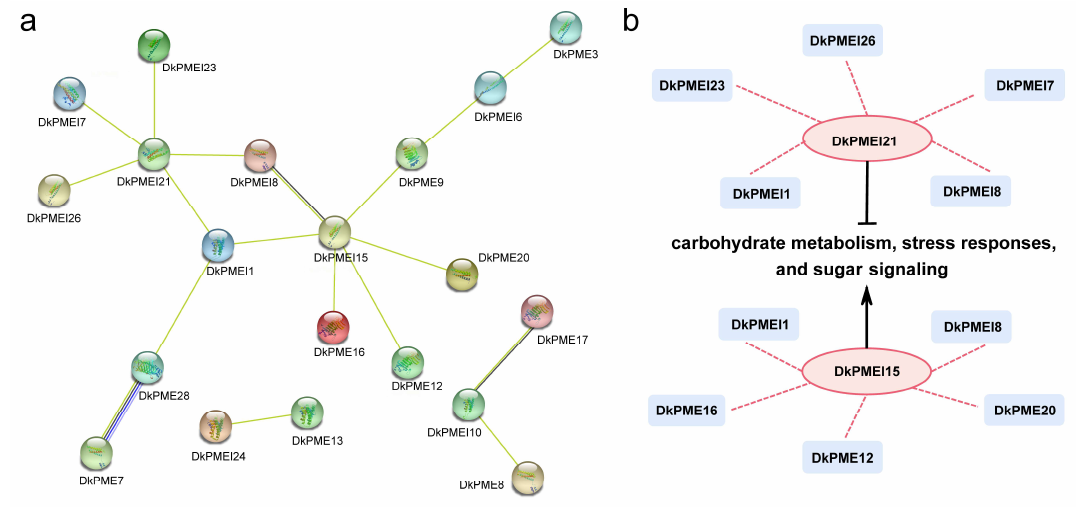
Figure 9. Functional network of DkPMEs and DkPMEIs: ( a ) Network of DkPMEs and DkPMEIs based on the orthologous genes in A. thaliana . ( b ) A schematic representation of a regulatory network among DkPMEs and DkPMEIs.